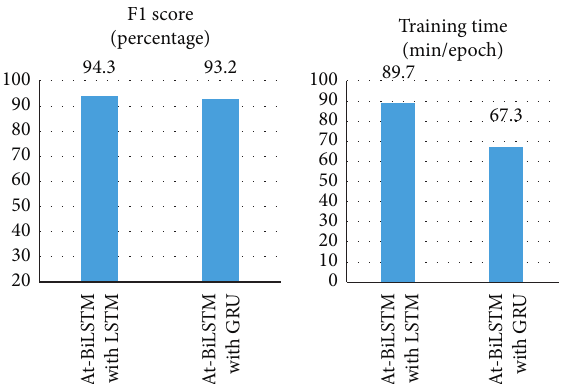
Figure 9: Performance of At-BiLSTM with LSTM and GRU on